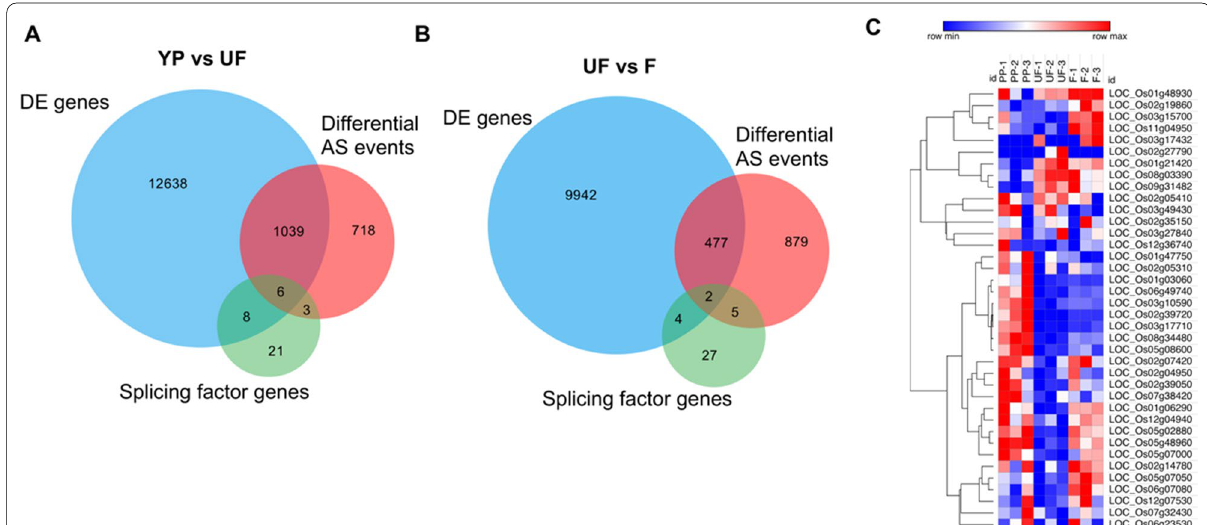
Fig. 3 Comparison between differentially expressed (DE) genes and differentially AS genes. a Venn diagram showed number of DE genes associated with differential AS genes and splicing factors in the comparison of YP versus UF. Differentially expressed and differentially expressed AS events derived from the splicing factor genes were identified. b Venn diagram showed number of DE genes associated with DAS genes and splicing factors in the comparison of UF versus F. Differentially expressed and differentially expressed AS events associated with the splicing factor genes were identified. c Expression pattern of splicing factors showed in heat map. Gene ID of spicing factors were listed in the heat map. The blue color represents low expression levels, and the red color represents the high expression